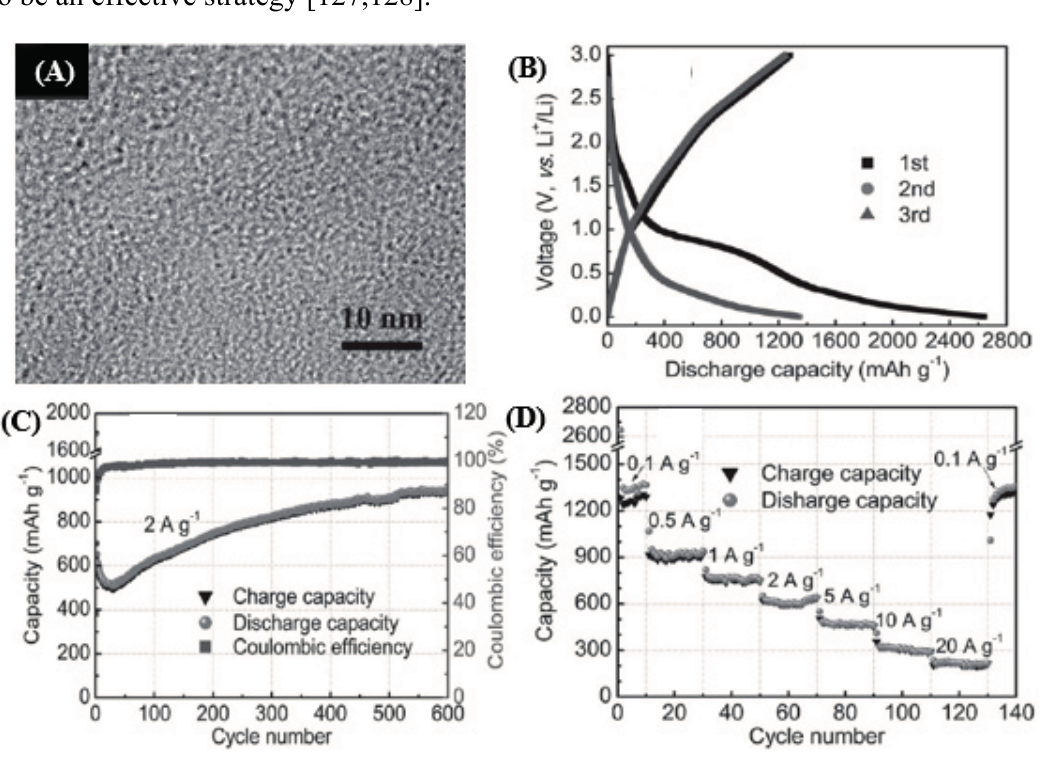
Figure 7. ( A ) HRTEM of carbon nanofiber webs (CNFWs) doped with